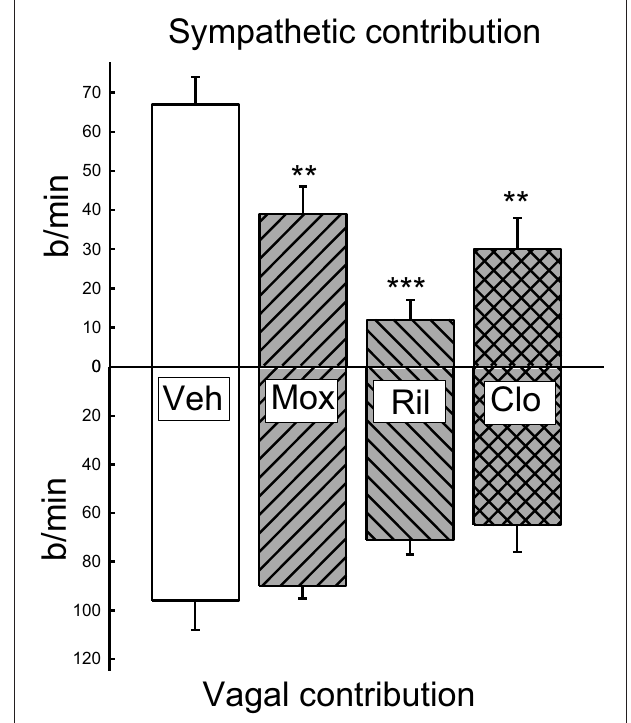
FIGURE 5 | Average contribution of the sympathetic and vagal influences on resting heart rate at 1 and 3 weeks of treatment in vehicle (Veh), moxonidine (Mox), Rilmenidine (Ril) and clonidine (Clo). Vagal contribution calculated as the change in heart rate induced by the administration of methscopolamine. Sympathetic component calculated as the heart rate under methscopolamine minus the intrinsic heart rate. The latter was estimated as 200 b/min according to the literature for rabbits at that body weight (Opthof, 2000). ** P < 0.01 and *** P < 0.001 for the effect of treatment compared to